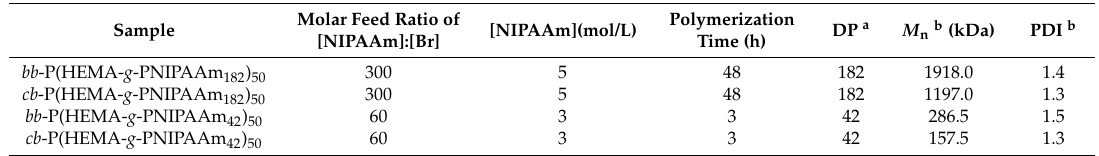
a Determined by 1 H NMR; b Determined by